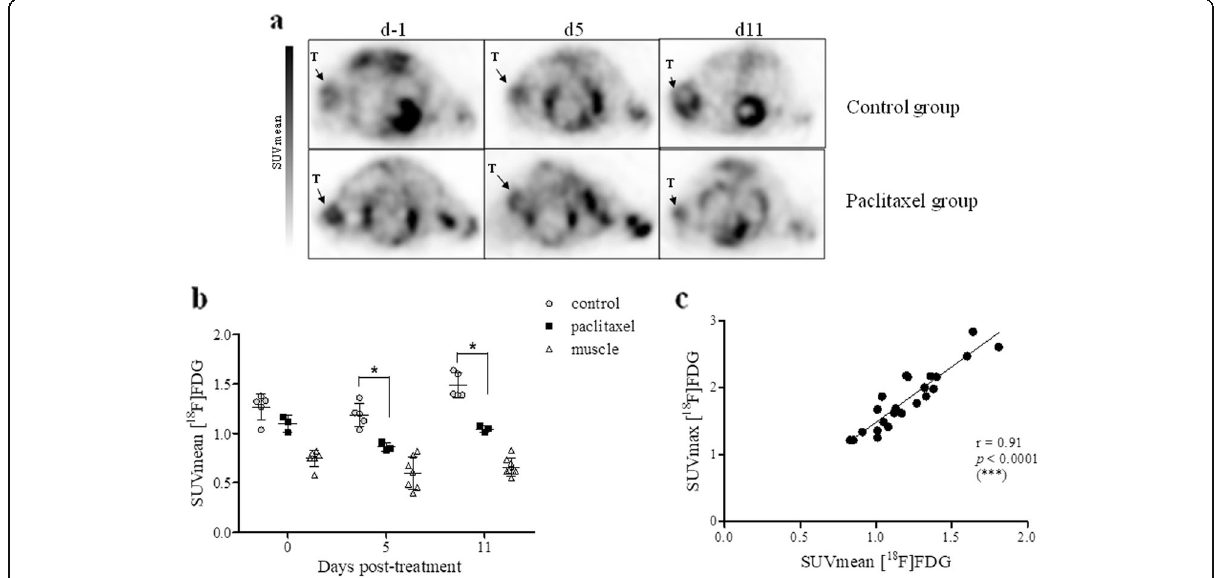
Fig. 9. Evaluation of early response by [ 18 F]FDG PET imaging on MDA-MB-468 subcutaneous model. a Images of [ 18 F]FDG PET of representative MDA- MB-468 subcutaneous xenograft model performed and day 5 and day 11 post-treatment. T represented Tumor. b [ 18 F]FDG uptake expressed as SUVmean in tumor control, tumor treated, and muscle before treatment and days 5 and 11 after treatment. Mann-Whitney test was performed (* p < 0.05). c Correlation between [ 18 F]FDG uptake expressed by SUVmean and SUVmax. Pearson correlation was performed (*** p < 0.001)